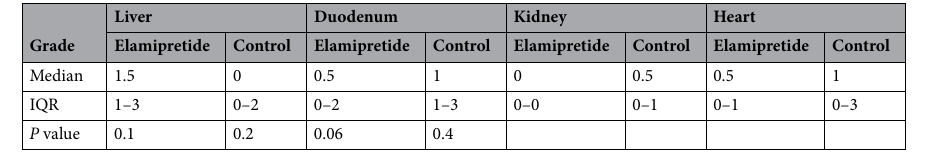
Table 3. Light microscopy tissue injury grading. IQR: interquartile range.